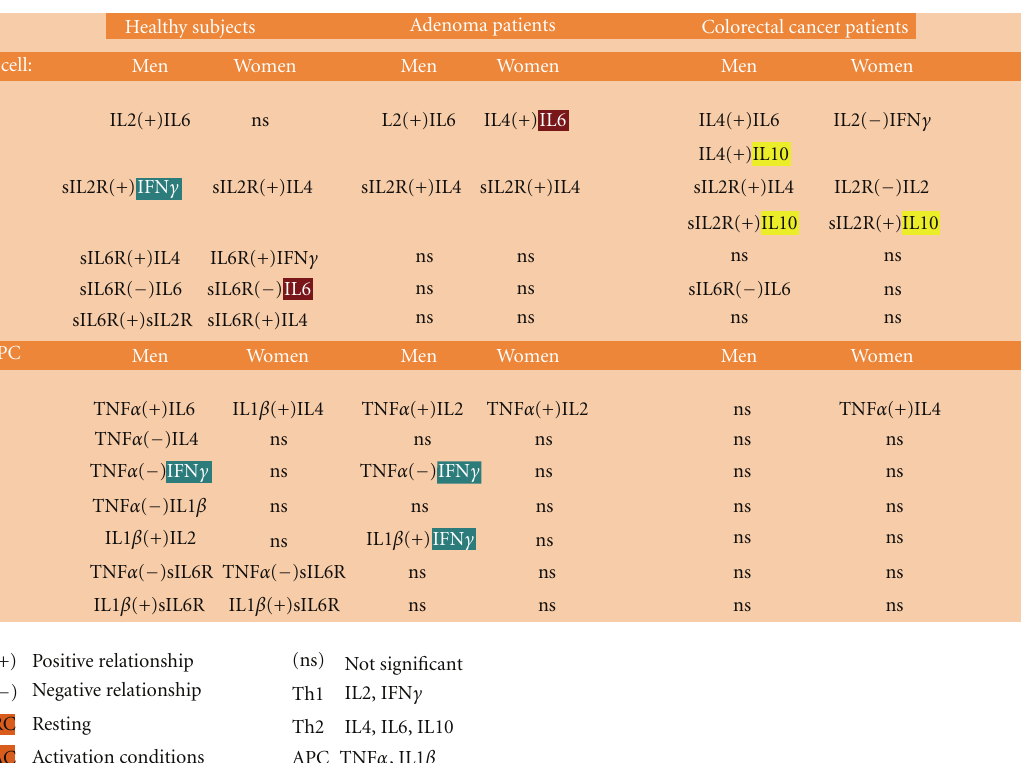
Figure 5: Serum Th1 and Th2 network relationships. Significant gender common and gender-specific Th1/Th2 network relationships were found in serum which could be used as biomarkers to indicate the direction of T cell di ff erentiation in the immune response. Positive relationship (+); negative relationship ( − ); resting (RC) and activation (AC) conditions; not significant (ns); Th1: IL2, IFN γ ; Th2: IL4, IL6, IL10; APC: TNF α , IL1